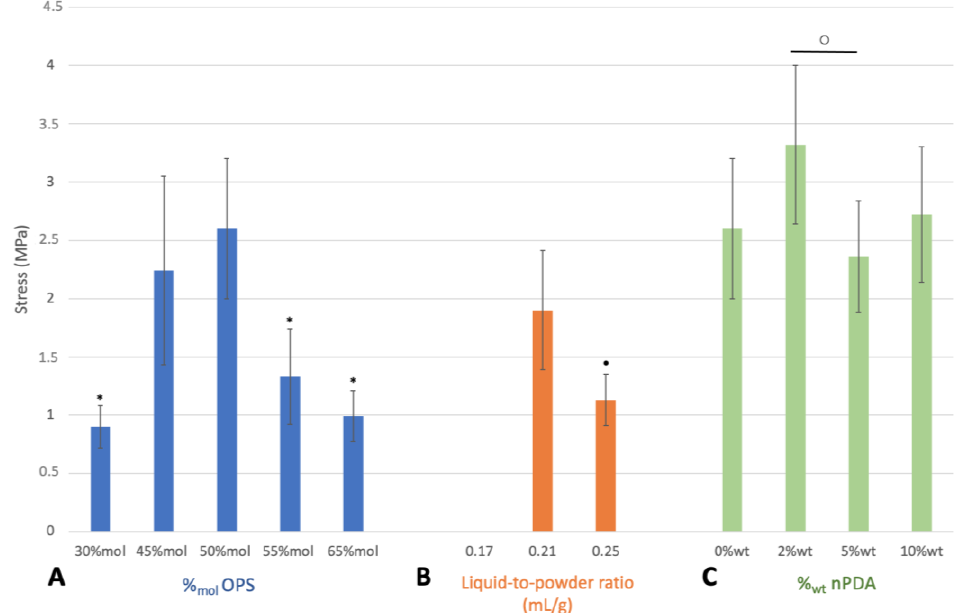
Figure 1. Characterization of nPDA with diffusion light scattering showing an average diameter of 190 nm and a polydispersity of 0.23 ( A ), and with scanning electron microscopy showing spherical particles uniformly distributed ( B ).